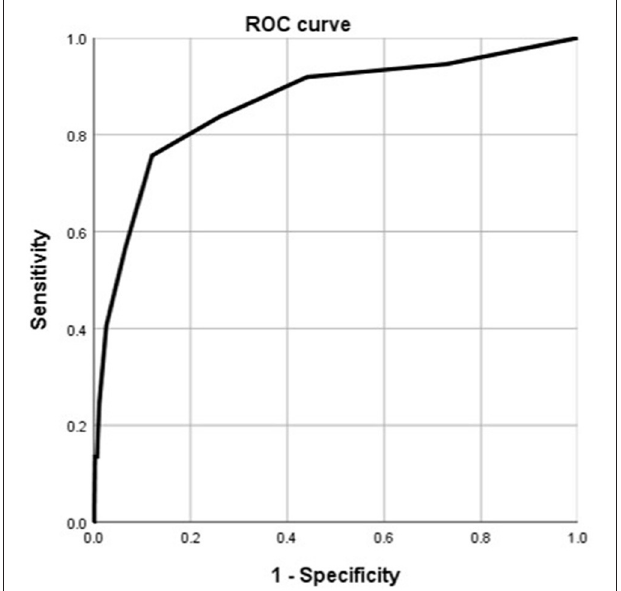
FIGURE 8 | Using number of comorbidities for discriminating the severe cases from the non-severe patients ( n = 718; non-severe and severe groups, n = 681 and 37, respectively). ROC analysis showing the performance of number of comorbidities in distinguishing severe cases from non-severe patients. ROC, receiver operating characteristic curve; AUC, area under the curve.